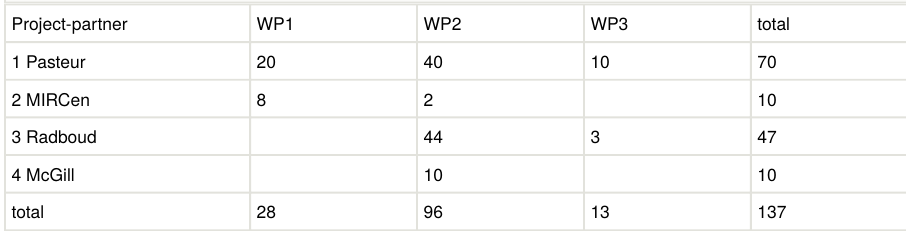
Project-partner WP1